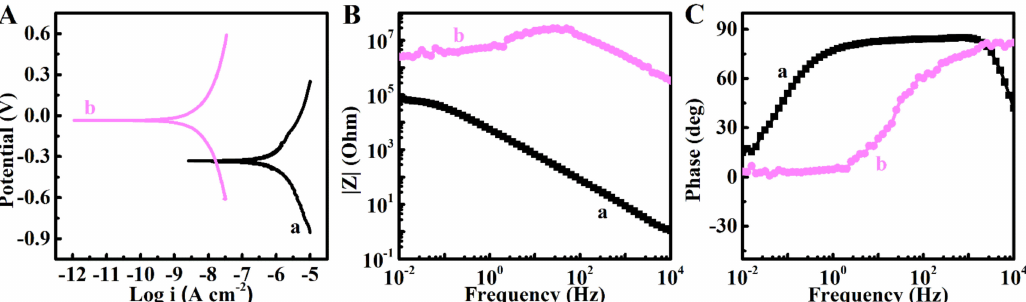
Figure 3. ( A ) Tafel dependences, and ( B , C ) Bode graphs for ( a ) uncoated substrate and ( b ) substrate coated with PMMA. The coating was prepared from 10 g L − 1 solution of PMMA with R wip = 0.25. Testing was performed in aqueous 3% NaCl using saturated calomel electrode as a